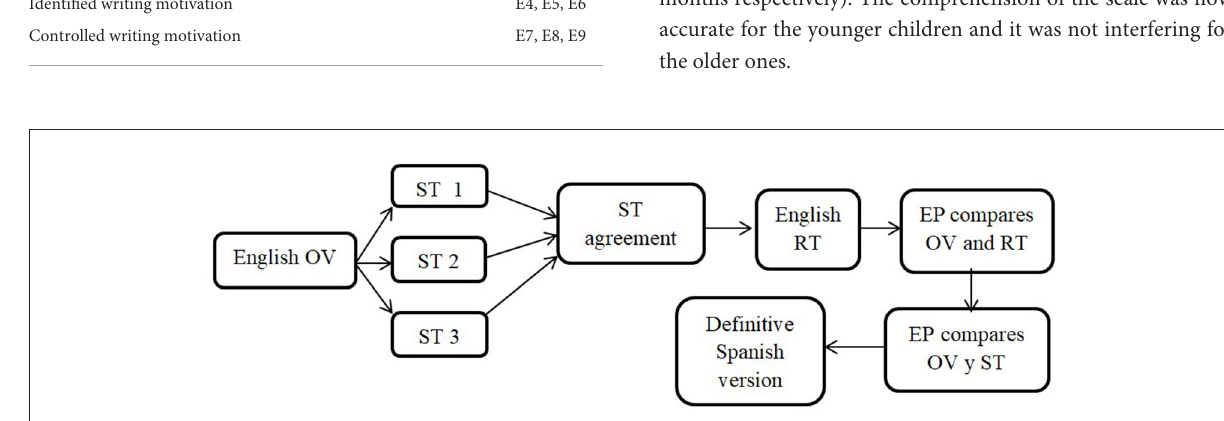
FIGURE2 Scale translation